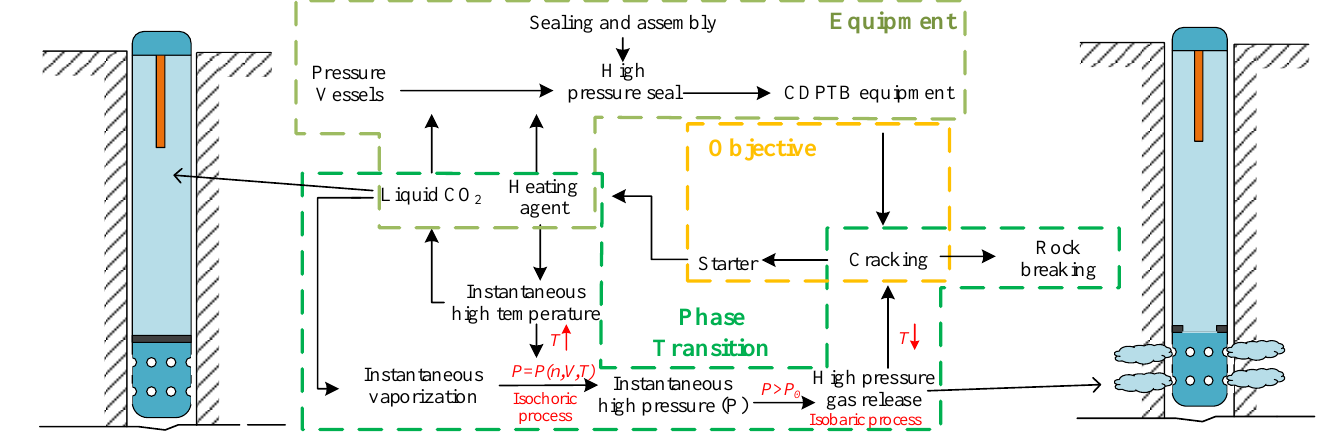
Figure 1. Principle of carbon dioxide phase transition